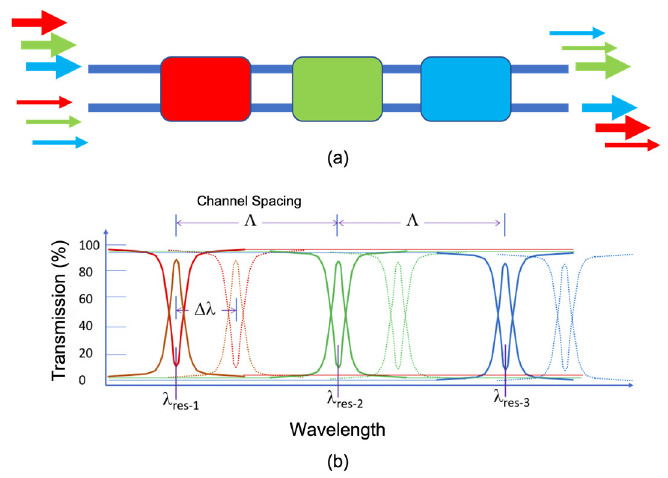
Figure 11. Block diagram of ( a ) the 2 × 2 × 3λ multicrossbar switch in a series connection of three resonant devices, and ( b ) the overall spectral response for the two states of each constituent.